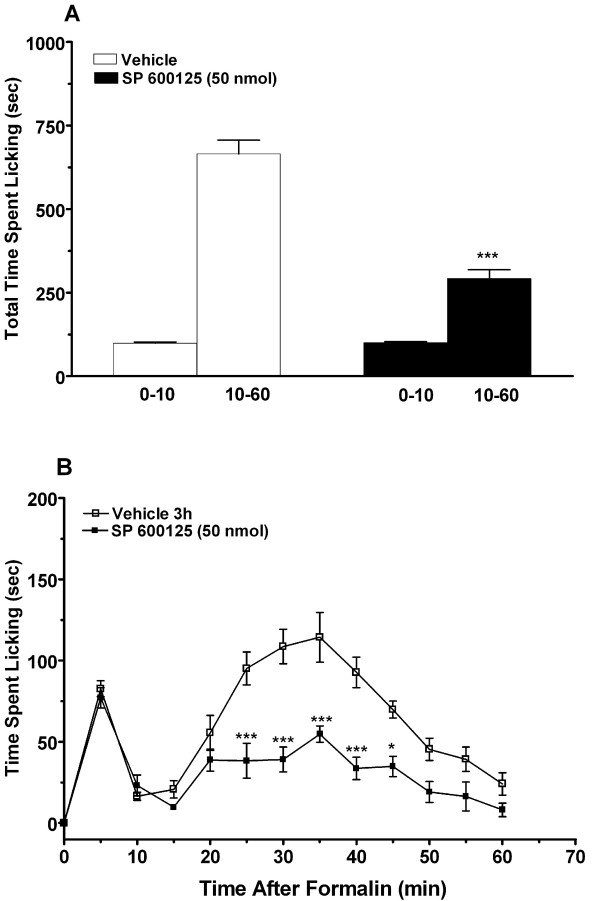
The effects of the JNK inhibitor, SP 600125, on formalin-induced nocifensive behaviors. For these experiments groups of mice (n = 8) first underwent intrathecal injection of SP 600125 or vehicle 3 h prior to formalin injection. The total duration of licking/biting time during early (0-5 min) and late phase (10 k-60 min) of the formalin response were measured and averaged for either the entire phase (graph A) or in 5-min intervals (graph B). Bars and symbols represent mean ± S.E.M. *p < 0.05, ***p < 0.001 compared to the vehicle group.